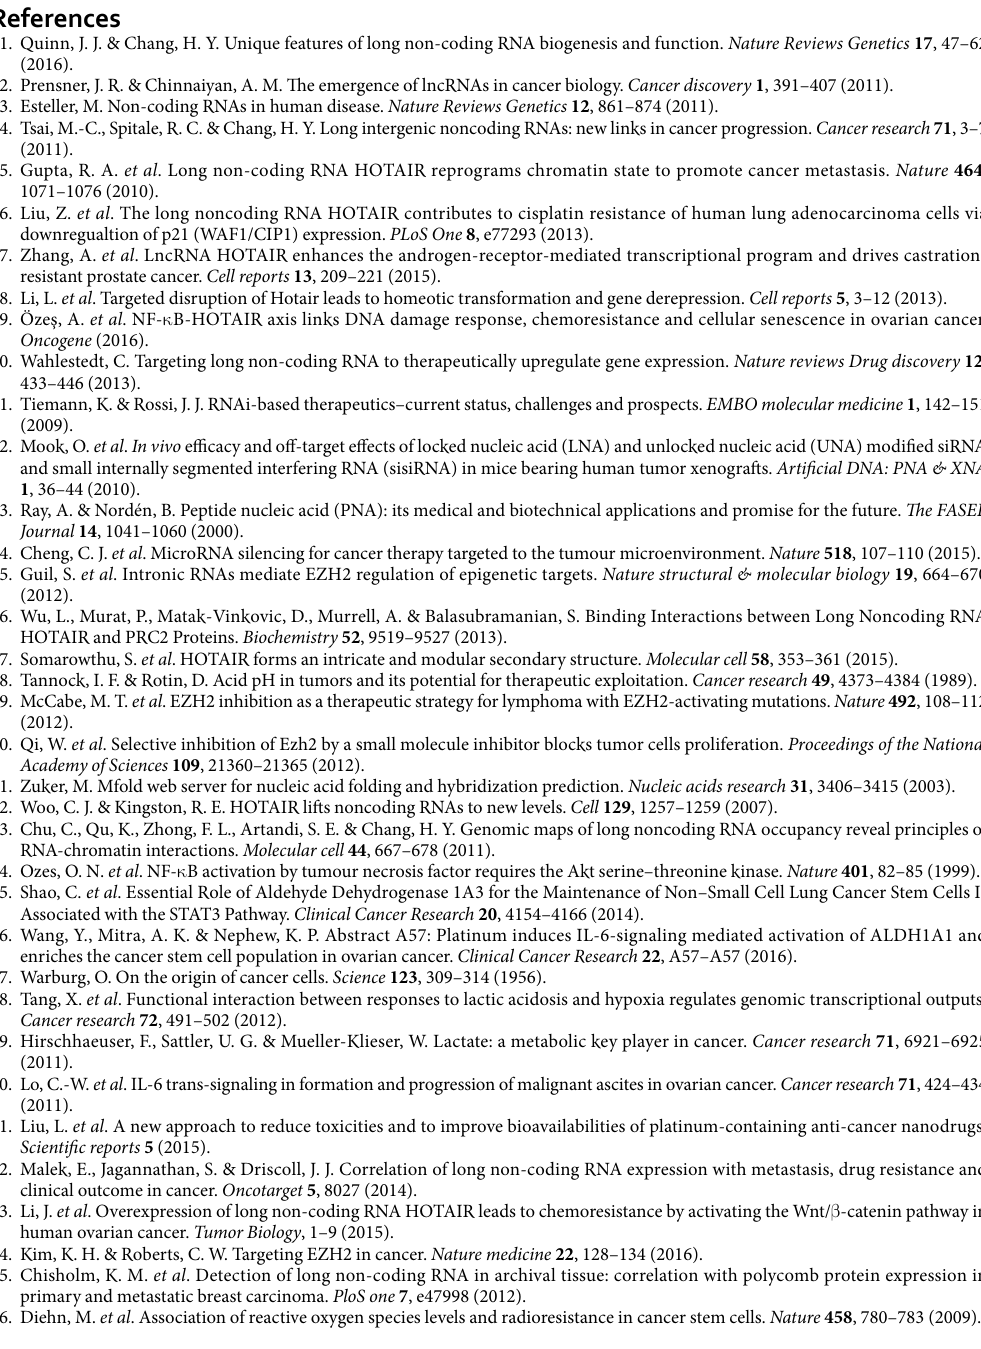
control (Supplementary Table S5), using Applied Biosystems 7500 Fast RT-PCR system (Life Technologies, Grand Island, NY) and corresponding software, as we have described 41 . Primers used for can be found in Supplementary Figure S4. Immunofluorescence quantification. A2780_CR5 cells were plated on glass slides (50,000 cells/well) and incubated at 37 °C, and 24 hrs later incubated with 100 nM cy3-pHLIP-PNA3 or cy3-pHLIP-Control PNA for 1 hr at 37 °C, washed 3x with 1x PBS. Slides were then prepared as described previously 9 . Statistical analysis. All data are presented as mean values ± SD of at least three biological experiments unless otherwise indicated. IC 50 values were determined by Prism 6 (GraphPad Software, San Diego, CA), using logarithm normalized sigmoidal dose curve fitting. The estimate variation within each group was similar there- fore student’s t -test was used to statistically analyze the significant difference among different groups by using Prism 4.0 (GraphPad Software). For mouse xenograft study, statistical significance was determined using student two-tailed